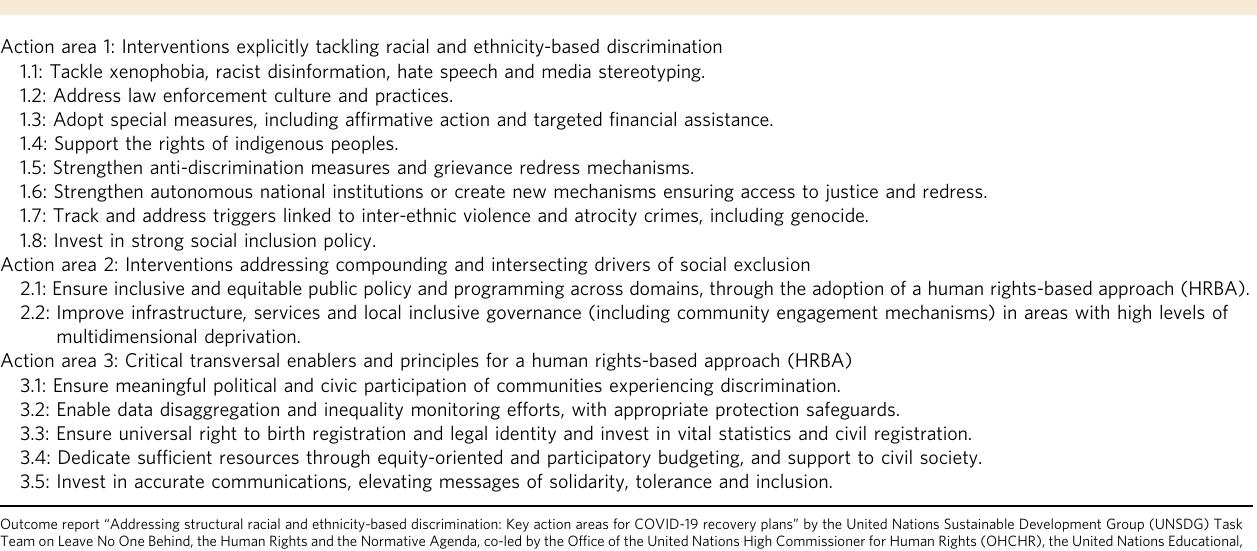
Table 1 Summary of potential entry points to address racial- and ethnicity-based discrimination, replicated from UN report. Action area 1: Interventions explicitly tackling racial and ethnicity-based discrimination 1.1: Tackle xenophobia, racist disinformation, hate speech and media